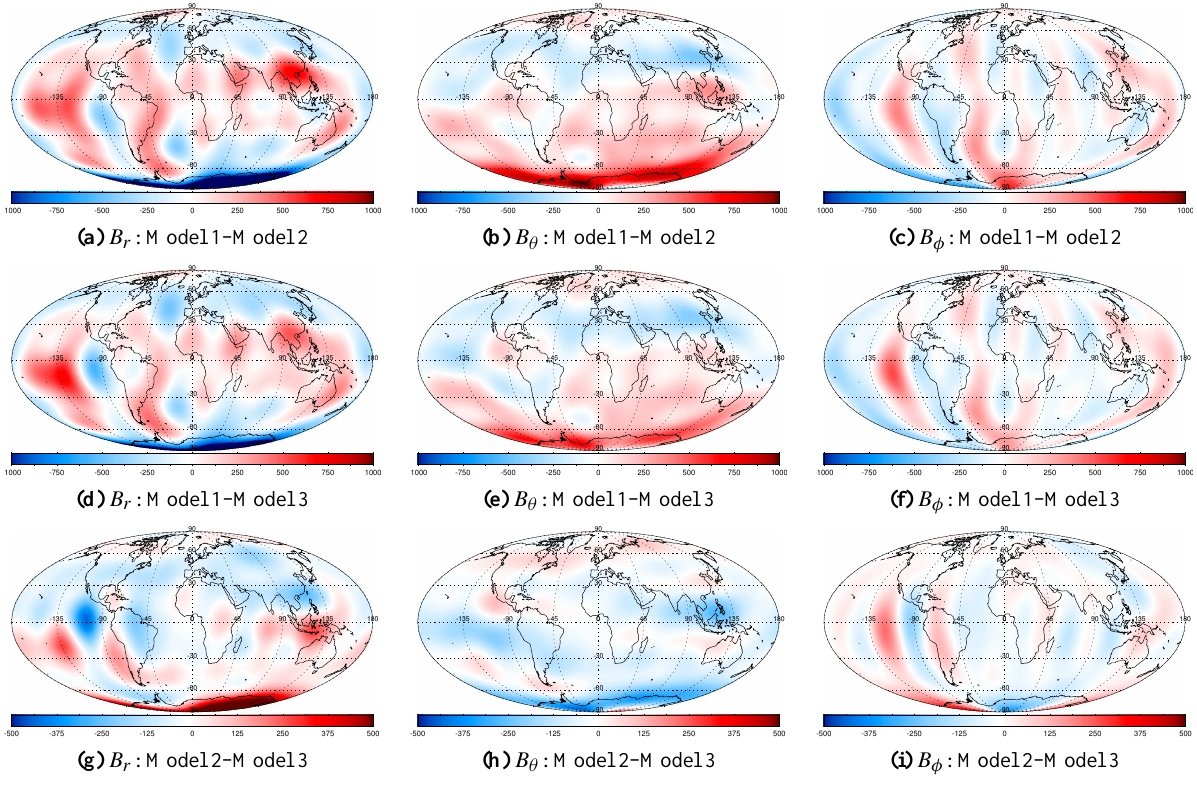
Fig. 11. Difference plots for Model 1–Model 2 ( a–c , ± 1000nT), Model 1–Model 3 ( d–f , ± 1000nT), and Model 2–Model 3 ( g–i , ± 500nT). Model 2 (uncorrected dayside data) and Model 3 (TIE-GCM corrected dayside data) show the largest difference in the southern polar